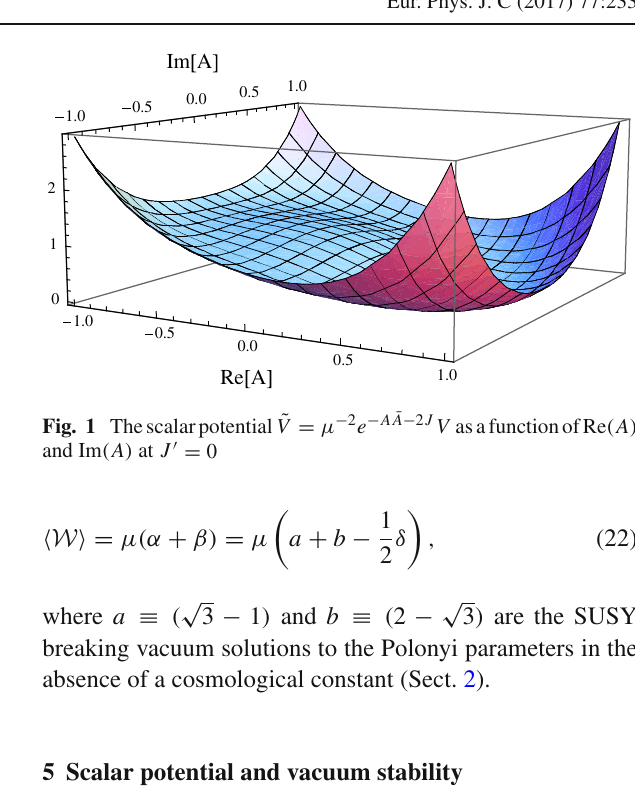
Fig. 1 Thescalarpotential ˜ V = μ − 2 e − A and Im ( A ) at J (cid:6) =